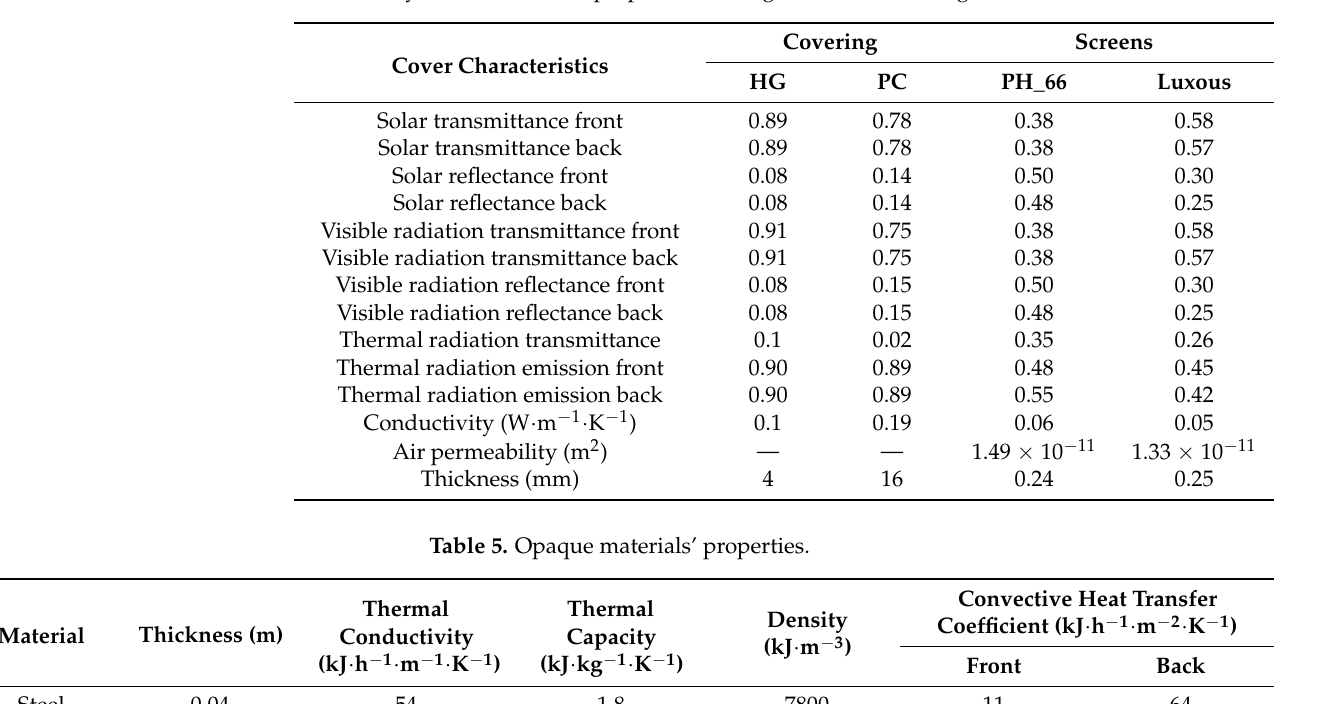
Table 4. Physical and thermal properties of the greenhouse coverings and thermal screens.